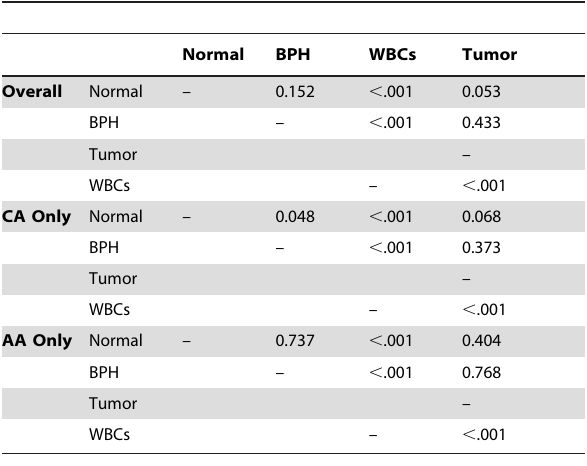
Table 8. Pairwise mtDNA comparison in normal, tumor, BPH, and